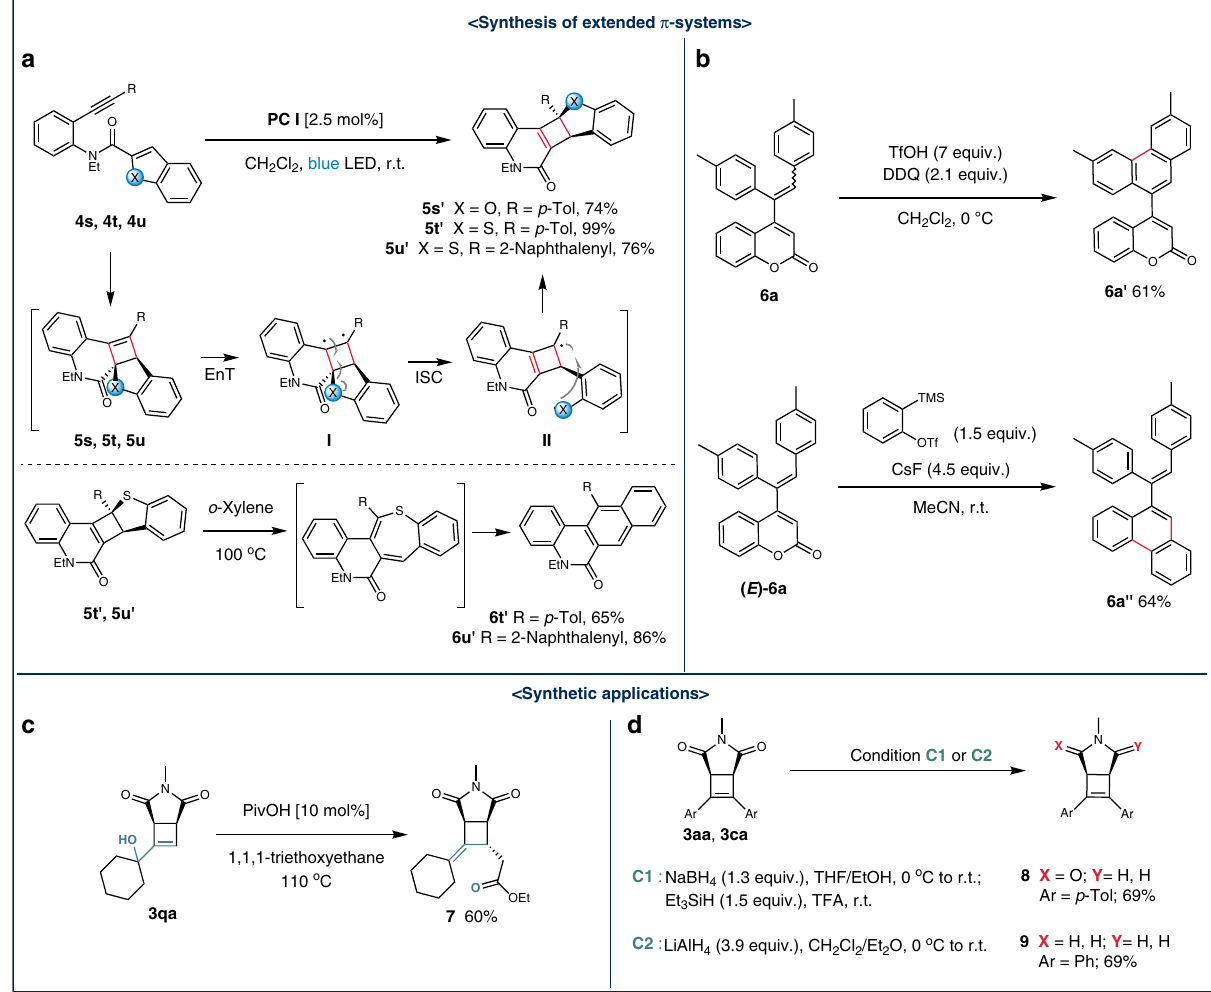
Fig. 4 Synthesis of extended π -systems and synthetic applications. Racemates for all cyclobutenes. a Tandem cycloaddition followed by rearrangement of benzofuran and benzothiophenes. (ISC = Intersystem crossing). b Derivatization of coumarin. (DDQ = 2,3-dichloro-5,6-dicyano-1,4-benzoquinone). c Synthesis of exomethylene cyclobutene. d Synthesis of γ -lactam and pyrrolidine